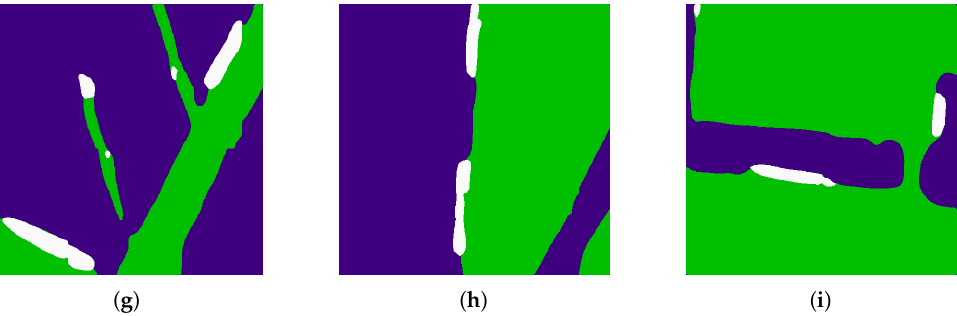
Figure 10. Zoomed in semantic labeling results of DenseCRF ( a - c ), SLIC ( d - f ) and proposed method ( g - i ) with original images ( top ). Here sea, land and ship are labeled as blue, green and white,